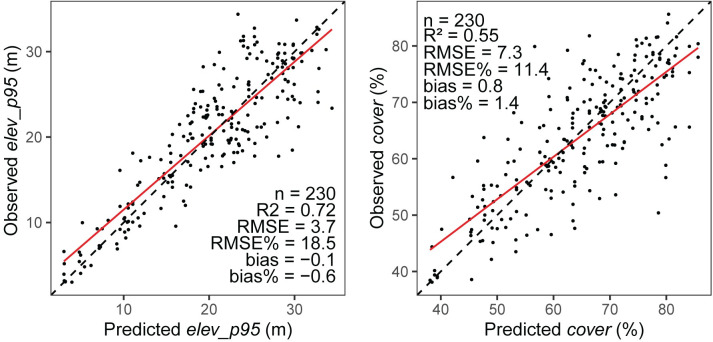
Scatterplots between observed and predicted elev_p95 (left) and cover (right). The 5 folds of the cross-validation are included in the plots. The solid red lines indicate the best linear regression fit.